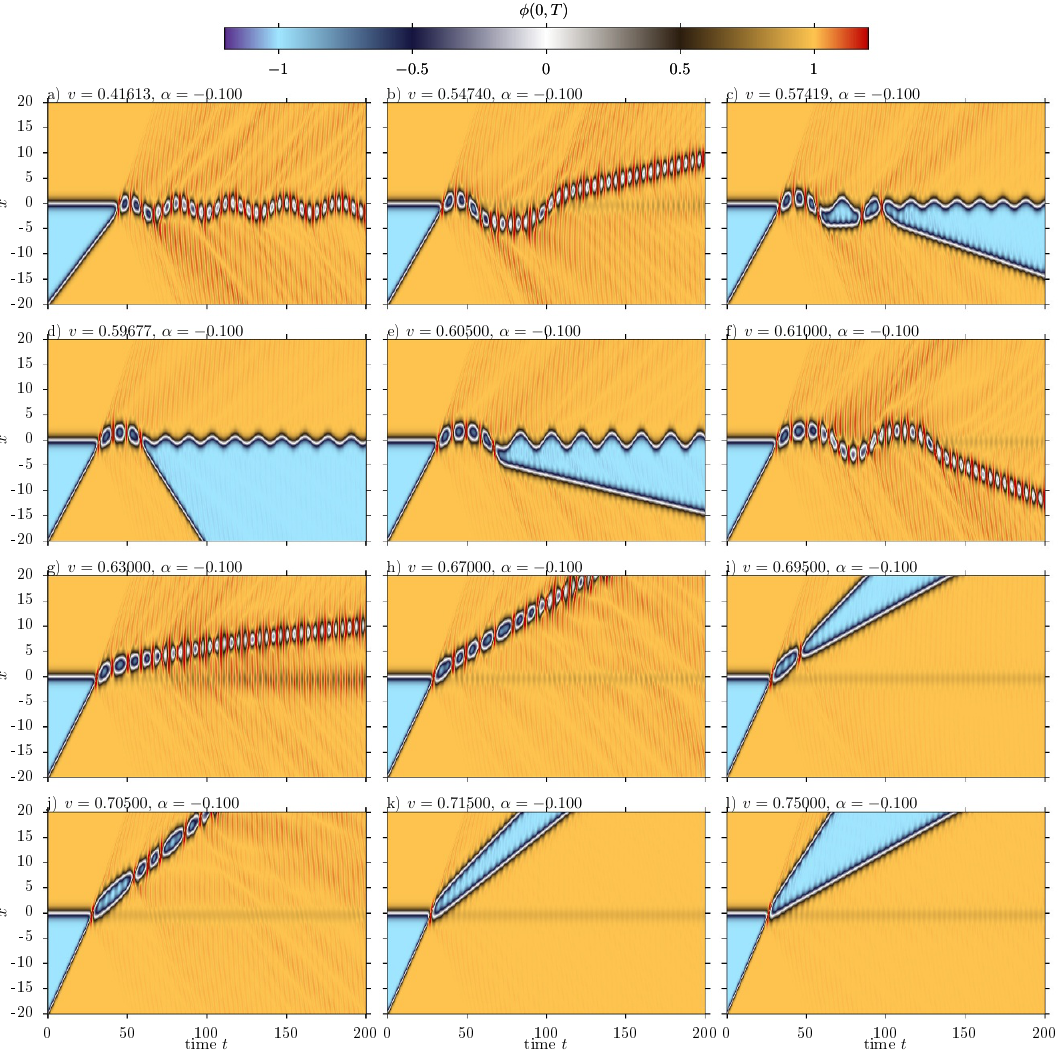
Figure 27 . Di(cid:11)erent scenarios of antikink-(kink-on-impurity) ( (cid:22) K + K 0 ) collisions with (cid:12)xed im- purity (cid:11) = (cid:0) 0 : 1 and di(cid:11)erent initial velocities of the incoming antikink. The velocity values are a) v = 0 : 41613, b) v = 0 : 5474, c) v = 0 : 57419, d) v = 0 : 59677, e) v = 0 : 605, f) v = 0 : 61, g) v = 0 : 63, h) v = 0 : 67, i) v = 0 : 695, j) v = 0 : 705, k) v = 0 : 715 and l) v = 0 : 75.